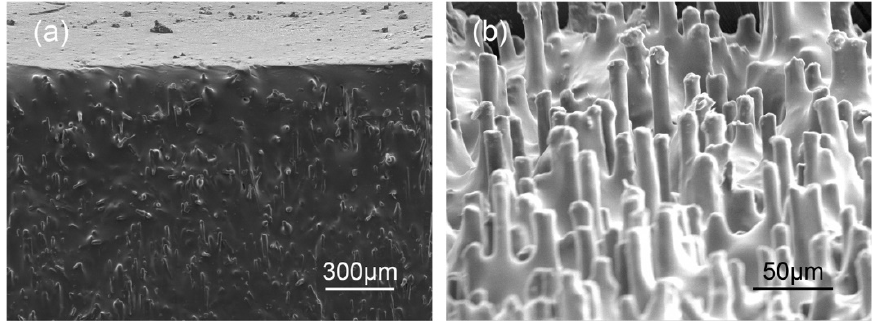
Figure 5. SEM images of the surface of the CF–rubber composites. ( a ) Before slicing ( b ) After slicing.